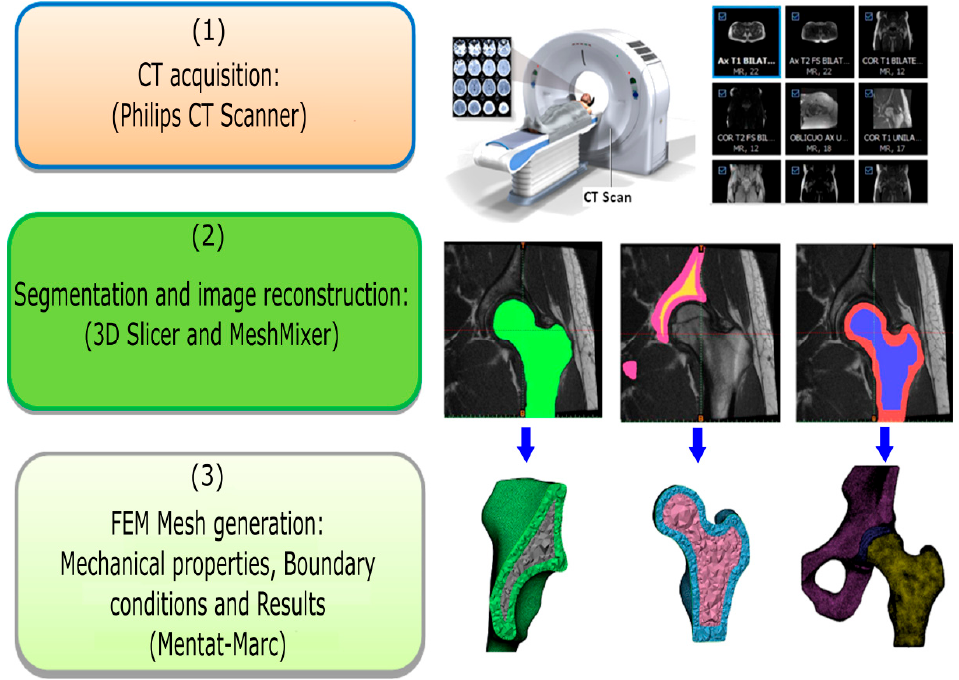
Figure 2. Steps followed to obtain the FE models from the patient’s CT scan.